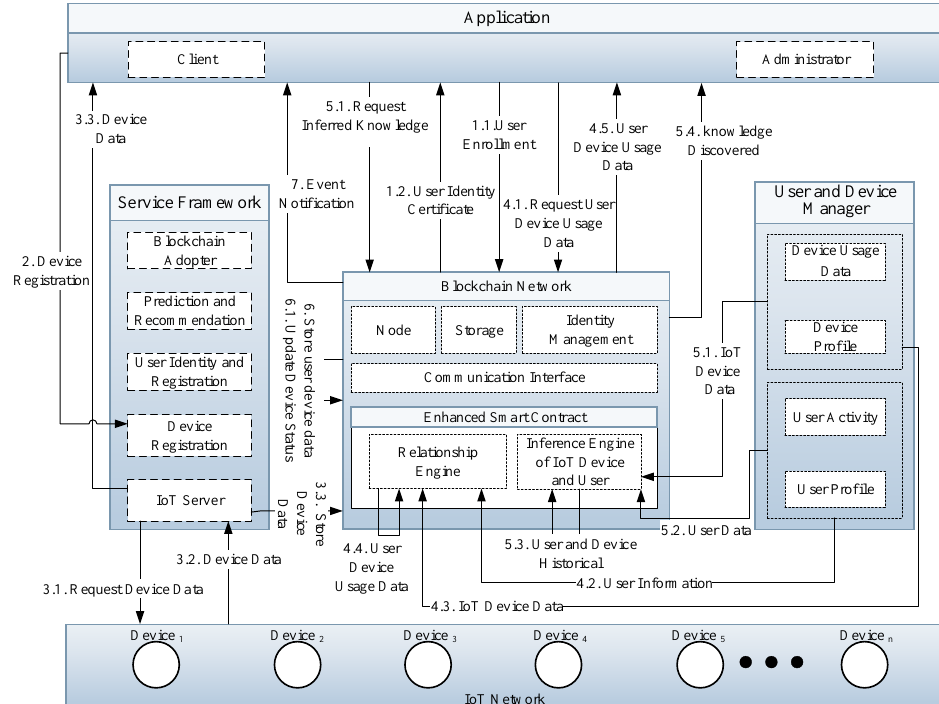
Figure 3. Detailed intelligent service configuration based on enhanced smart contract enabled relationship and inference engine in IoT